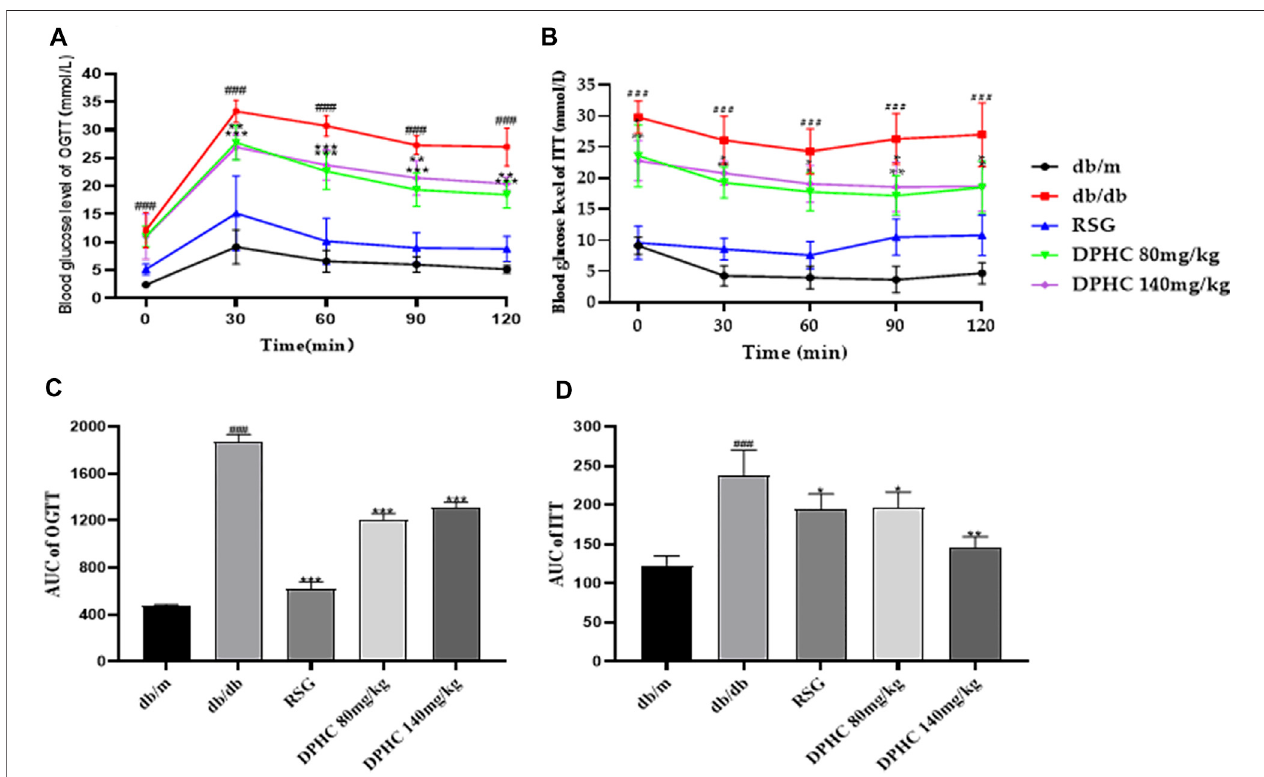
FIGURE3| EffectsofDPHConOGTTandITTindb/dbmice. (A) ThechangeinglucoselevelintheOGTT. (B) ThechangeinglucoselevelintheITT. (C) TheAUCof theOGTT. (D) TheAUCoftheITT.ThebaselinecorrectionoftheAUCofOGTTandITTwasconductedbasedonthelowestbloodglucosevalueofeachgroup.Allvalues are expressed as means ± SD, n (cid:1) 9. * p < 0.05, ** p < 0.01, *** p < 0.001 compared with the db/db group, and ### p < 0.001 compared with the db/m